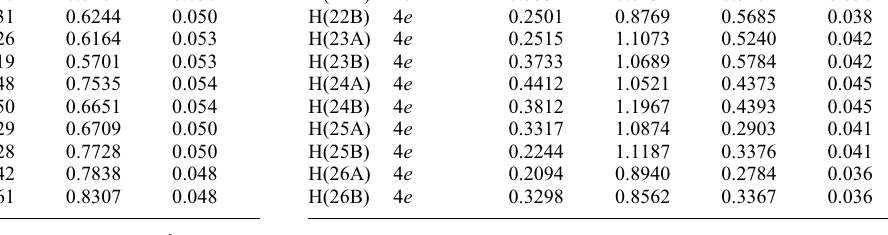
Table 3. Atomic coordinates and displacement parameters (in Å 2 ) .